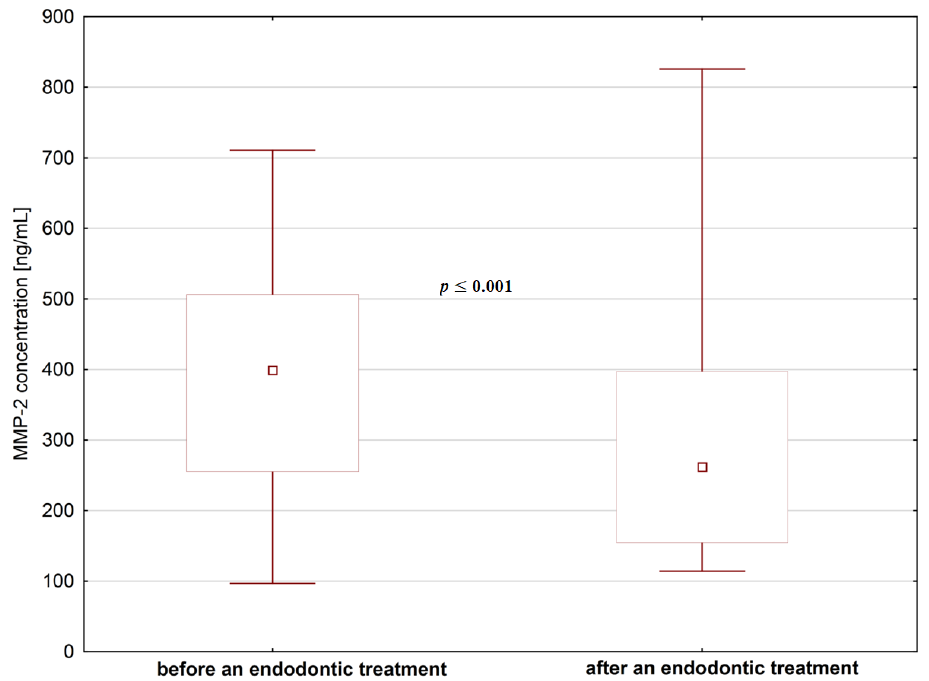
Figure 4. The concentrations of MMP-2 in saliva before and after endodontic treatment. J. Clin. Med. 2020 , 9 , 3971